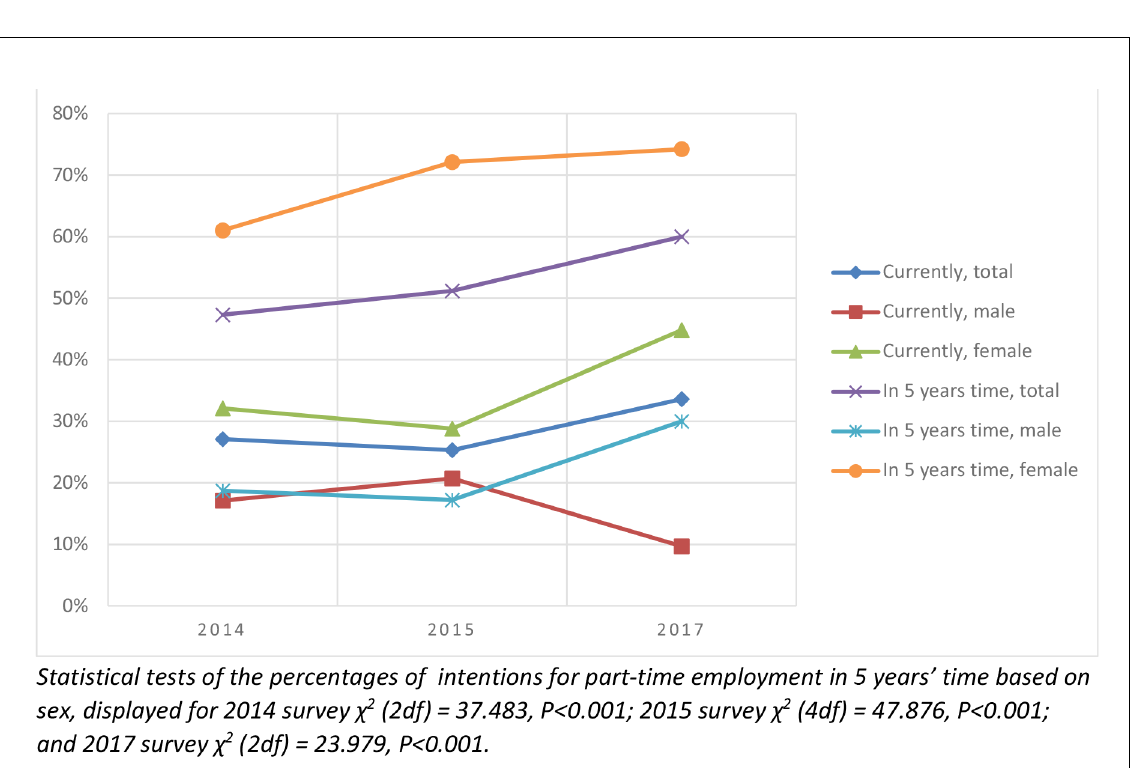
Figure 3. Part-time employment of recent GP graduates based on sex.